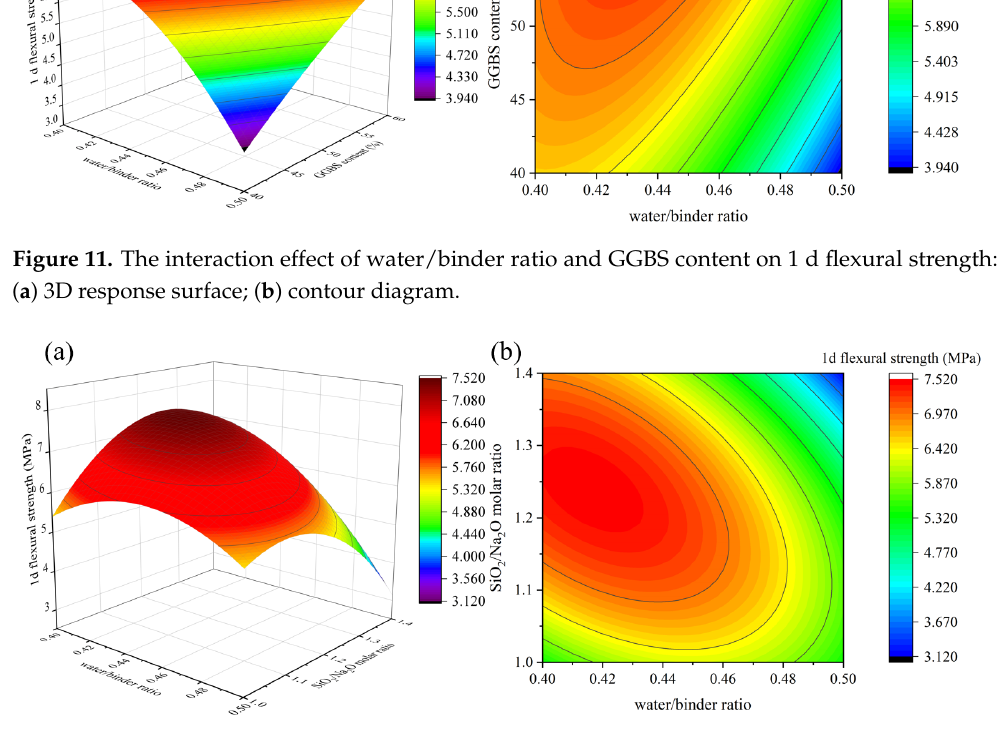
Figure 12 . The interaction effect of water/binder ratio and SiO 2 /Na 2 O molar ratio on 1 d flexural strength: ( a ) 3D response surface; ( b ) contour diagram.